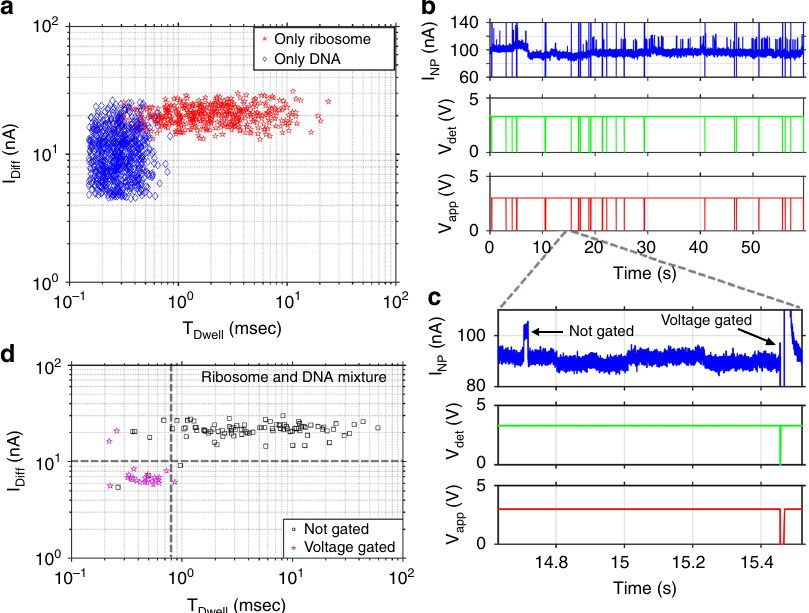
Fig. 4 Voltage-gated selection of speci fi c particles from a mixture. a Scatter plot of differential current vs. dwell time of translocation events when only λ - DNAs (blue) and only ribosomes (red) are drawn through the same nanopore. b Demonstration of selective voltage gating of λ -DNAs from a mixture of ribosome and λ -DNA; top: current through nanopore, center: speci fi c translocation detection pulses, bottom: voltage applied across pore; c zoomed-in view of panel b , revealing how speci fi c targets are voltage-gated while others are not gated. d Scatter plot of differential current vs. dwell time of each translocation event of panel b , where magenta points show voltage-gated translocations, and black points show the translocations which are not gated, with thresholds shown by dotted other particles with different translocation signatures. This can time vs. differential current of each translocation event of the enable, for example, fl uorescence experiments on a controlled control experiments are shown in Fig. 4a where only ribosomes number of DNAs while unlabeled particles (here: ribosomes) are (red) and only λ -DNAs (blue) move through the nanopore, ignored and discarded. Now, the circuit has to not only respond respectively. Figure 4a shows that translocations with differential to the leading edges of a translocation; rather, it must analyze the amplitude less than 10 nA and dwell time less than 0.8 ms are full translocation (amplitude, duration) pattern in real time and generated by λ -DNAs, and these values are used as criteria for respond rapidly enough for selective gating. Scatter plots of dwell selective gating of DNAs into the fl uidic channel. Note that a